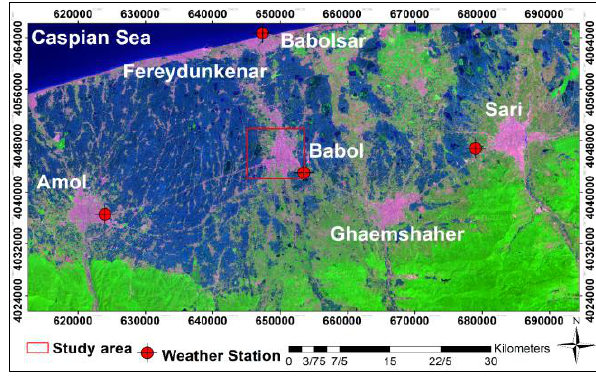
Figure 1. Location of the studied